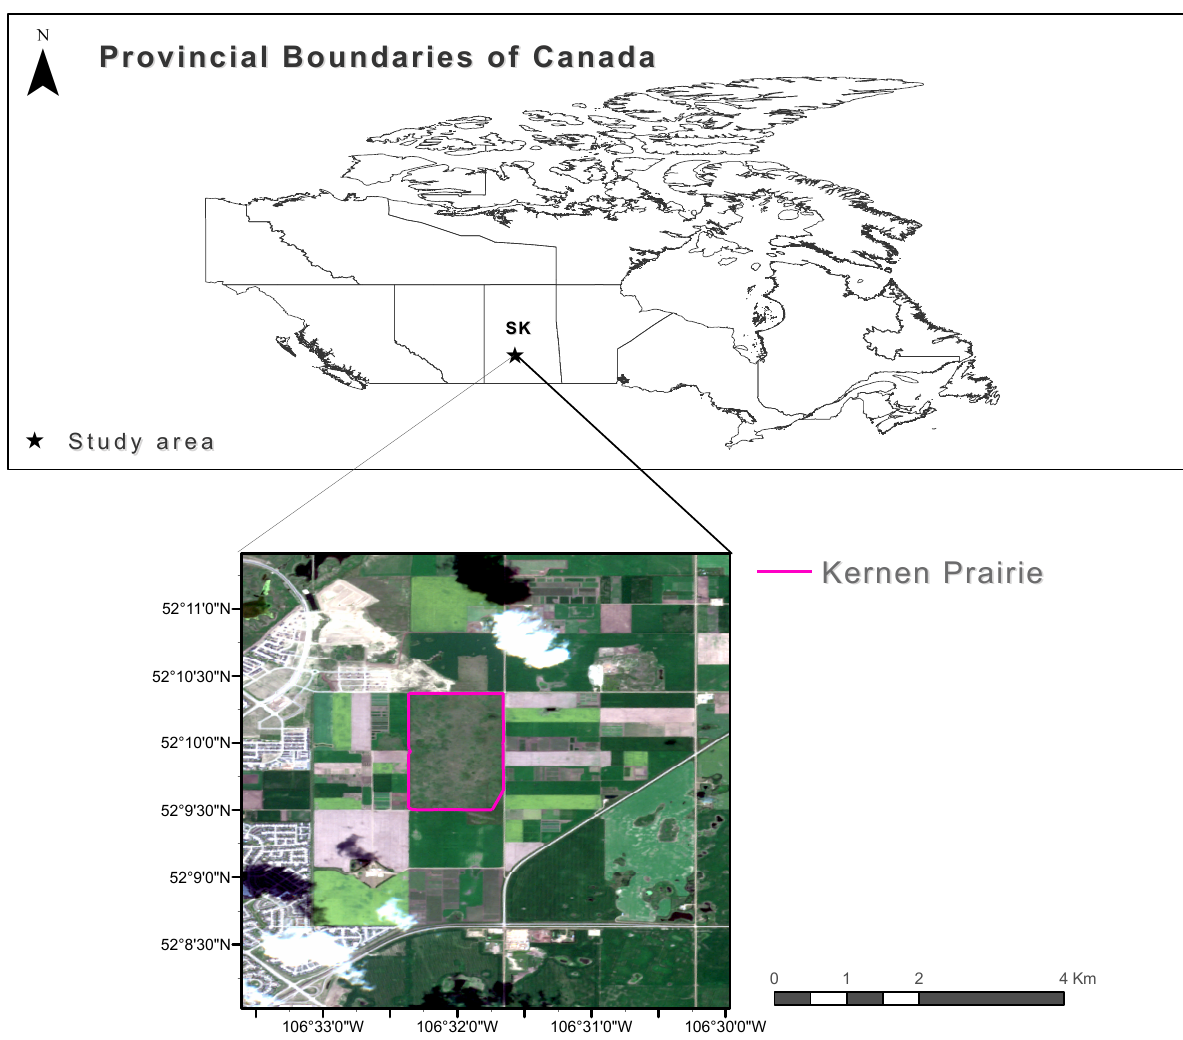
Figure 1. Location of Kernen Prairie within the provincial boundaries of Saskatchewan (SK), Canada ( upper figure ), and on a Sentinel-2 image of 11 July 2020 ( lower figure ). Source of Canadian Provincial Boundaries: Statistics Canada (Open-Government License—Canada) [41], source of Sentinel-2 image: ESA (‘Copernicus Service information 2020’ for Copernicus Service Information) [42], source of Kernen Prairie boundary layer: Department of Plant Science, University of Saskatchewan (Dr. Eric